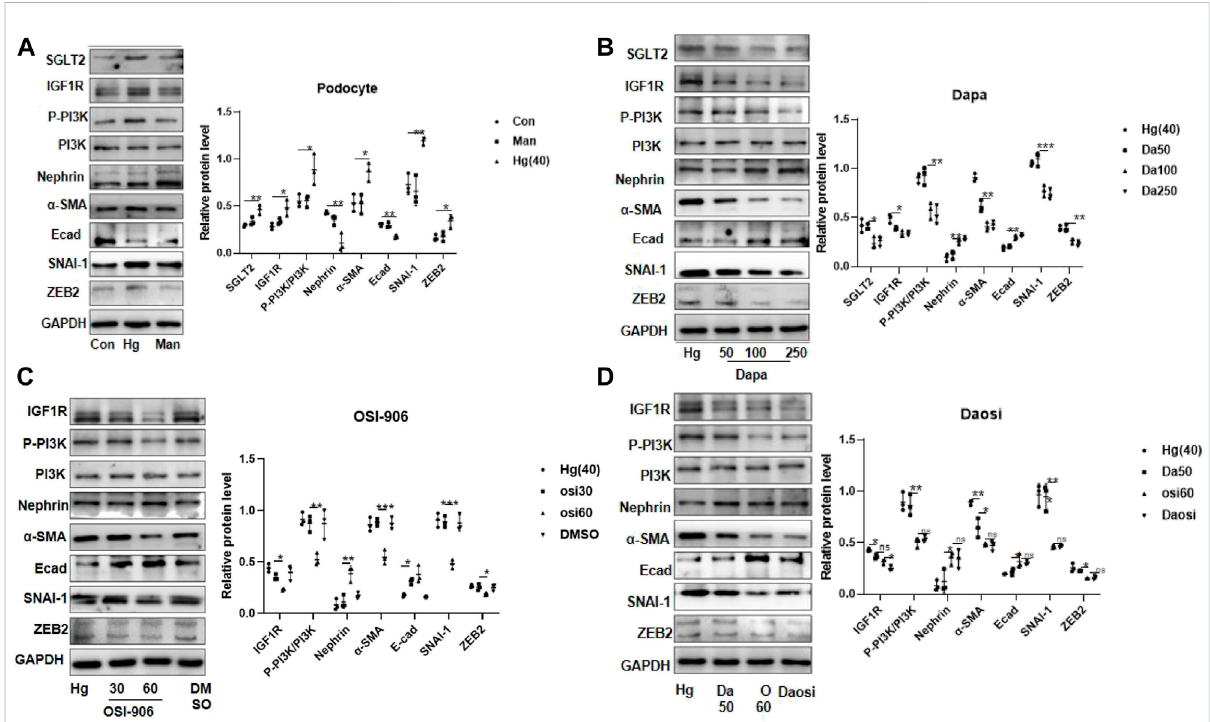
FIGURE 4 SGLT2 directly regulated podocyteEMT via IGF1R/PI3K signaling. (A) Representative WBimagesand densitometricanalysis oftheexpressionof SGLT2,IGF1R,phosphorylated PI3K, andEMTmarkers inhigh-glucose-stimulated podocytes (Hg: 40 nM, 24 h). (B) Podocytes treated withdifferent doses of dapagli fl ozin (50 nM, 100 nM, and 250 nM) and (C) OSI-906 (30 nM and 60 nM). (D) Combination of OSI60 and Da50.